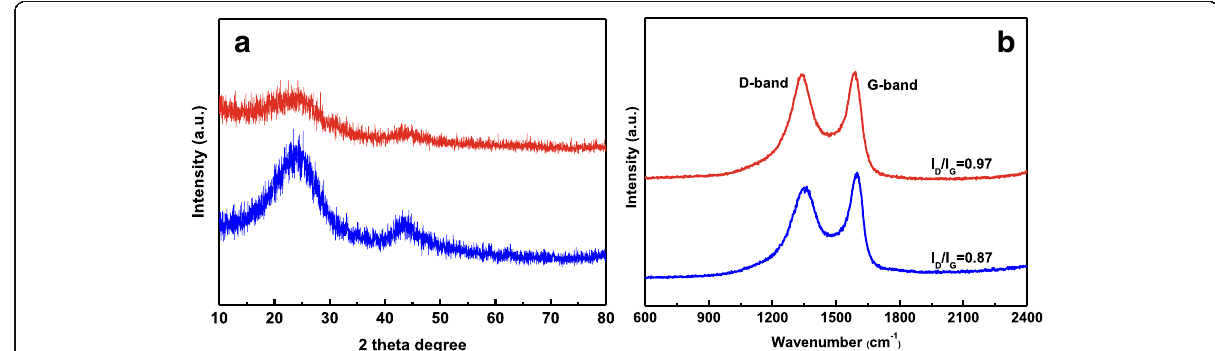
Fig. 2 XRD patterns and Raman spectra. a XRD patterns and b Raman spectra of CGCF ( blue line ) and CGACF ( red line